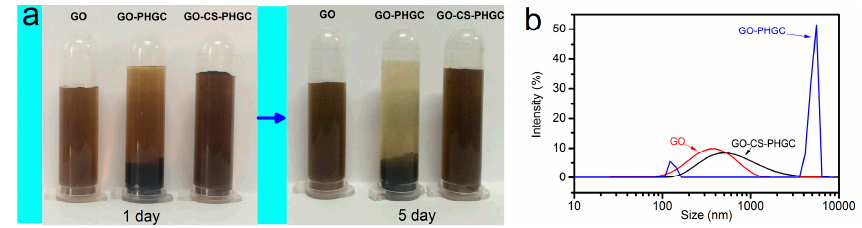
Figure 2. ( a ) Photographs of GO, GO-PHGC and GO-CS-PHGC dispersions after standing still for 1